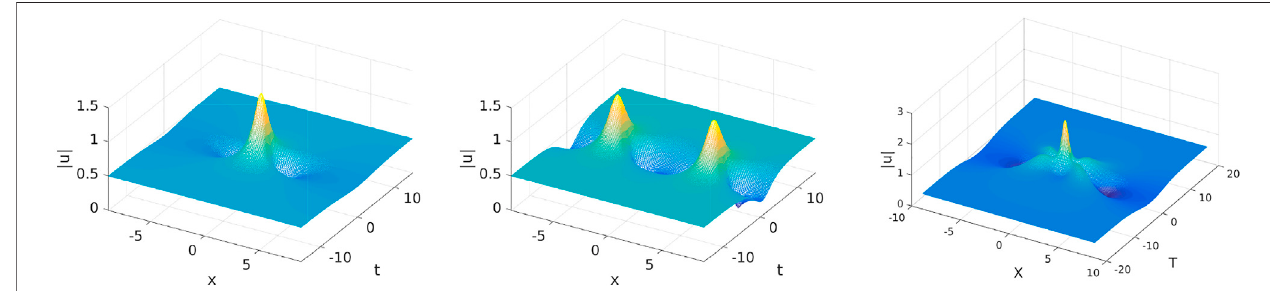
(cid:14)(cid:14) √ π :Amplitudesof (A – B) singlemodeSPBs 2